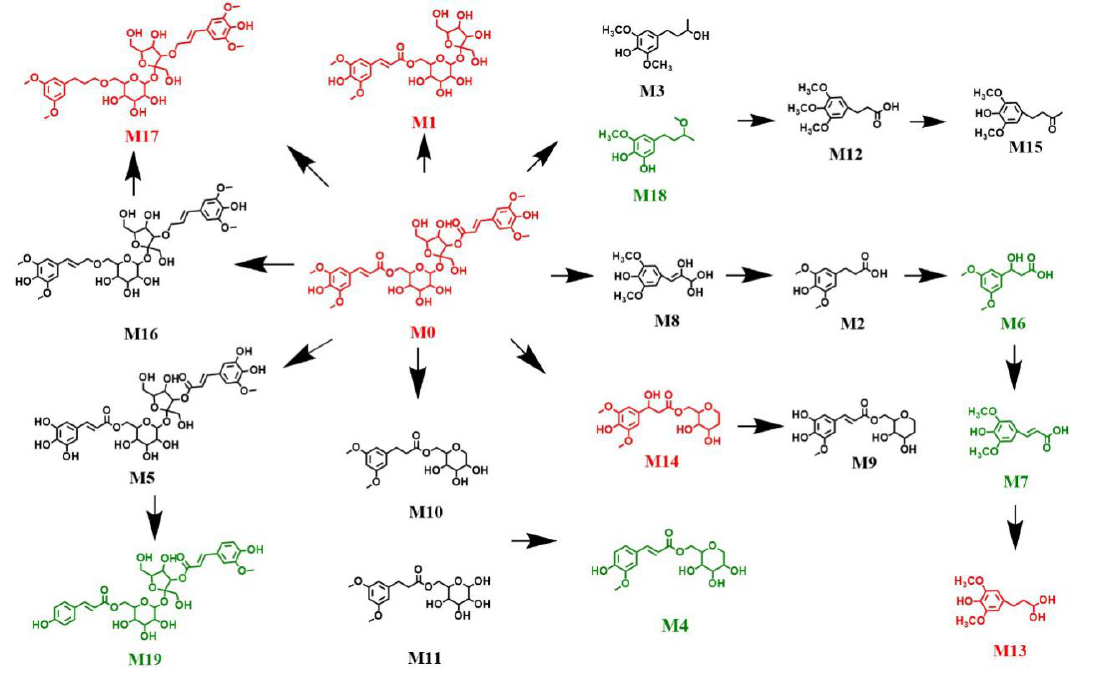
Figure 7. Metabolic pathways of DISS in